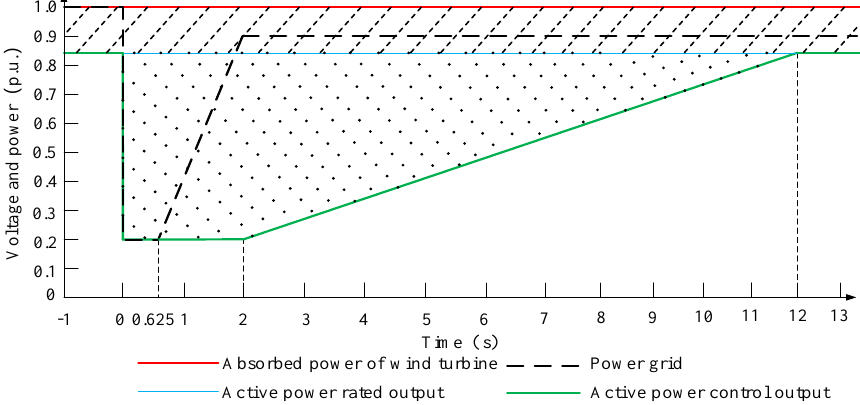
Figure 4. LVRT energy transmission variation rule.